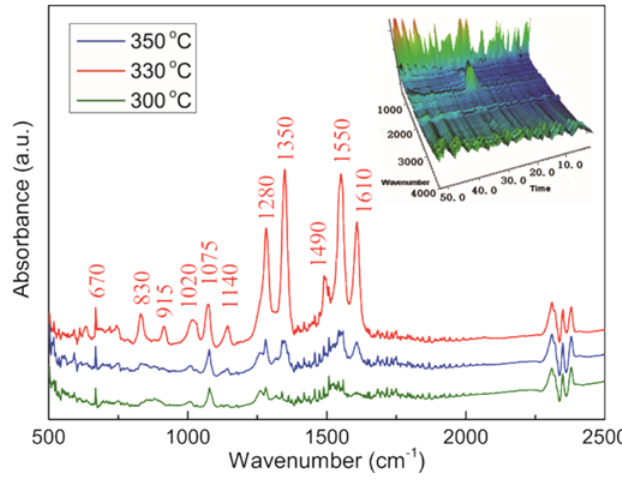
Figure 4. FTIR spectra of time-resolved decomposition products of TNAN.